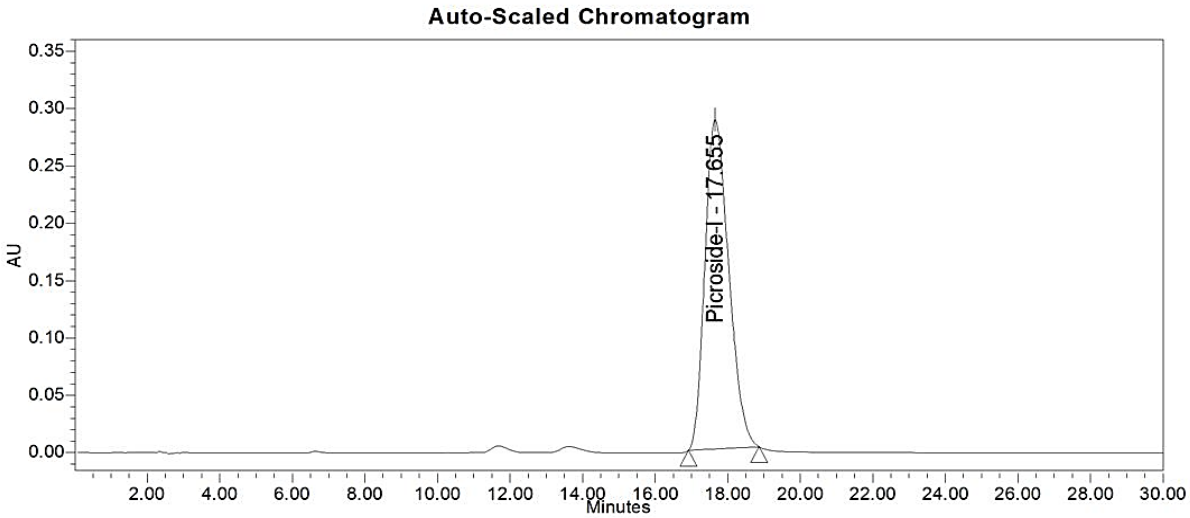
Figure 4. The HPLC spectra of picroside–1. Table 3. Antimicrobial potential of picroside–1 compounds against Yersinia enterocolitica . Ethanolic